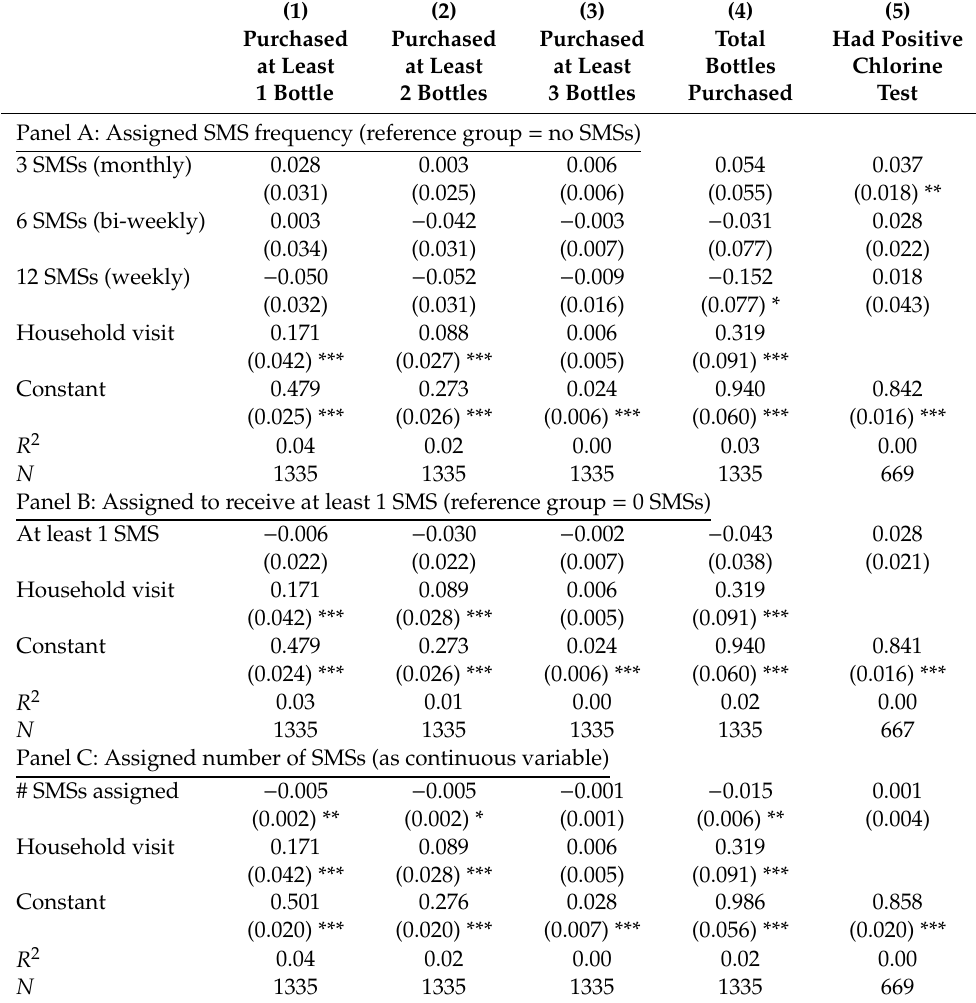
Table 3. Impact of di ff erent SMS frequencies (intention-to-treat (ITT)